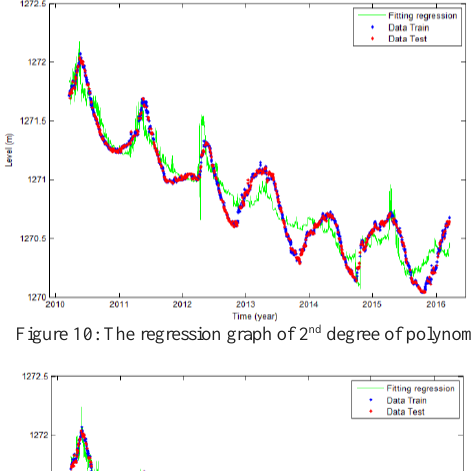
Figure 8: Level of water changes over the period of 2010-2016